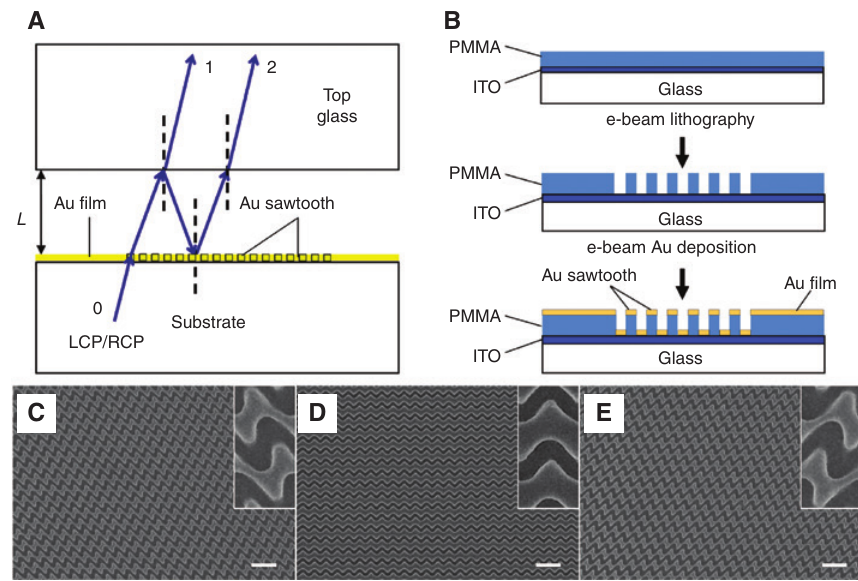
Figure 1: Phase measurement and fabrication of complementary Au sawtooth metasurface. (A) Schematic for the measurement of reflection phase using transmission of circularly polarized, LCP/RCP, incidence light. (B) Fabrication procedures of complementary Au sawtooth metasurface. (C)–(E) SEM images of N -, V - and И -type sawtooth metasurfaces, respectively. The white scale bars are 1 μ m. The width of the Au sawtooth on the bottom layer is about 135 nm for the vertical bar and 110 nm for the slanted bar for the N - and И -type sawtooth metasurfaces while it is about 120 nm for both slanted arms of the V -type sawtooth metasurface. Insets are enlarged images of the Au sawtooth unit